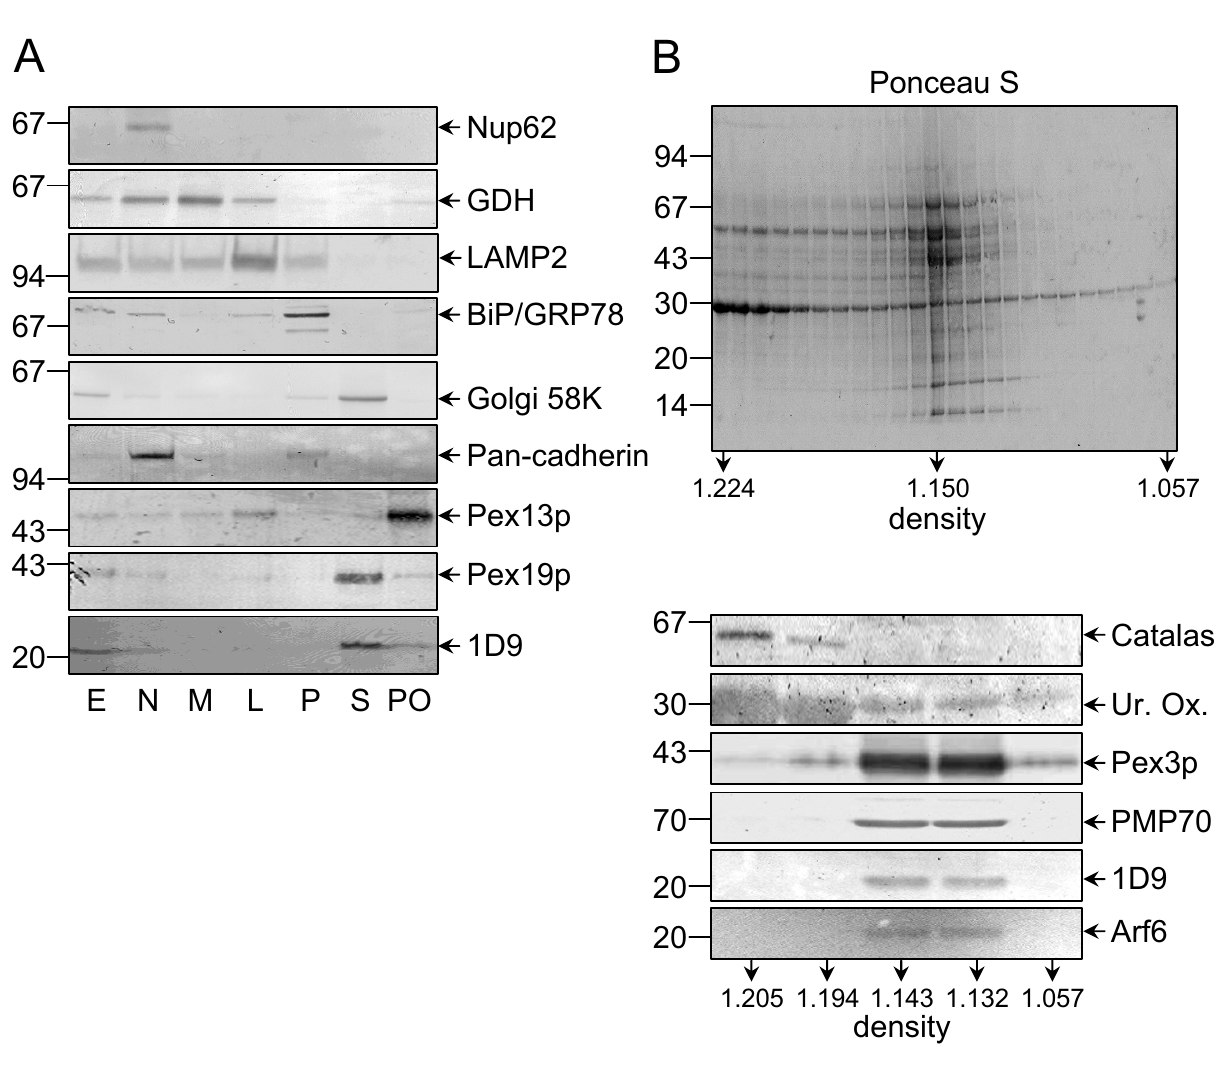
Figure 2 Arf6 copurifies with the peroxisomal membrane fractions . (A) Rat liver homogenates were fractionated into a postnu- clear (E), a nuclear (N), a heavy mitochondrial (M), a light mitochondrial (L), a microsomal (P), and a cytosolic (S) fraction. A peroxisome-enriched fraction (PO) was obtained by centrifugation of the L-fraction on a Nycodenz step gradient (see Meth- ods). Equal amounts of protein were subjected to SDS-PAGE, transferred to nitrocellulose, and immunoblotted with antibod- ies raised against the nuclear pore complex protein p62 (Nup62), mitochondrial glutamate dehydrogenase (GDH), lysosomal- associated membrane protein 2 (LAMP2), the ER-resident chaperone immunoglobulin binding protein (BiP/GRP78), the micro- tubule-binding peripheral Golgi membrane 58 kDa protein (Golgi 58 K), the plasma membrane protein pan-cadherin (Pan-cad- herin), the peroxisomal membrane protein Pex13p (Pex13p), peroxisomal biogenesis factor 19 (Pex19p), or a linear epitope found in Arf proteins (1D9). Note that the majority of Golgi 58 K is soluble after fractionation, and that Pex19p is a predomi- nantly cytosolic, partly peroxisomal protein. (B) Six milligrams of total protein from the peroxisomal fraction was processed for floatation centrifugation in an alkaline sucrose gradient (see Methods). The fractions were collected from the bottom, proc- essed for SDS-PAGE, transferred to a nitrocellulose membrane, and stained for total protein with Ponceau S (upper panel). A select set of fractions was immunoblotted with anti-Arf 1D9 or antibodies against Arf6 or peroxisomal matrix (catalase), core (urate oxidase), or membrane proteins (Pex3p, PMP70) (lower panels). The density (in g/ml) of the gradient fractions and the migration of the molecular mass markers (their masses expressed in kDa) are